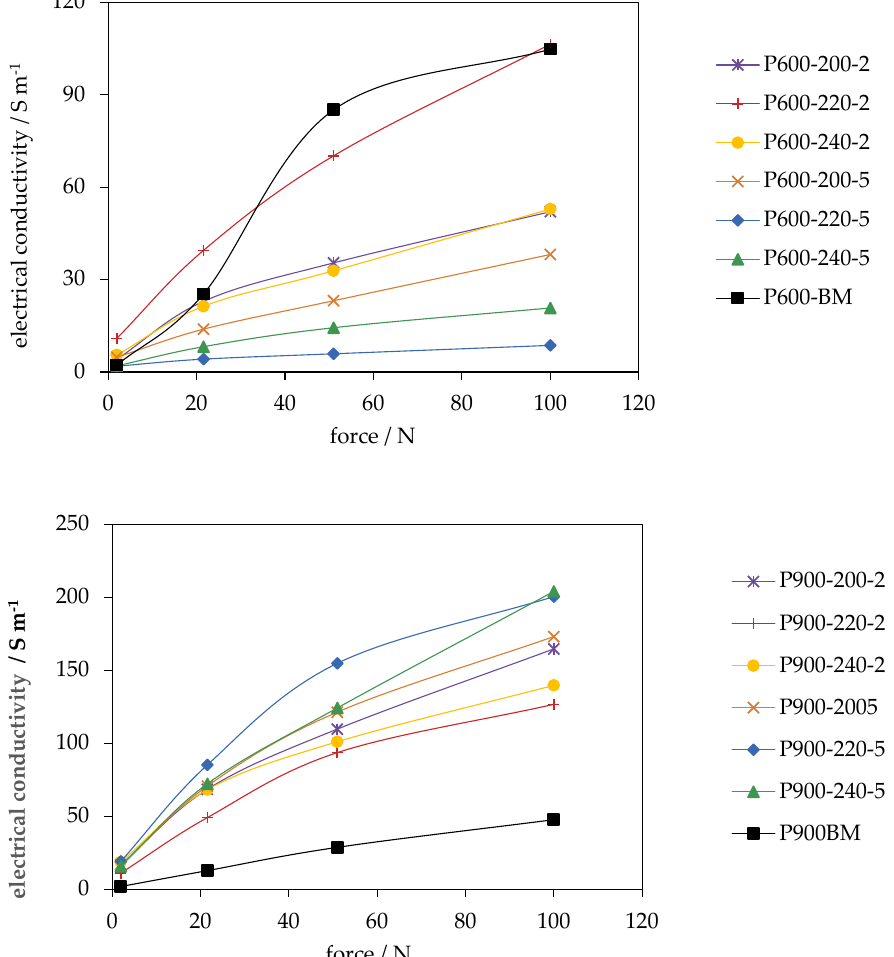
Figure 8. Electrical conductivity of PHC600 and PC600 ( top ) and PHC900 and PC900 ( bottom ) with increasing compression ( ± max. 10 S m − 1 ).